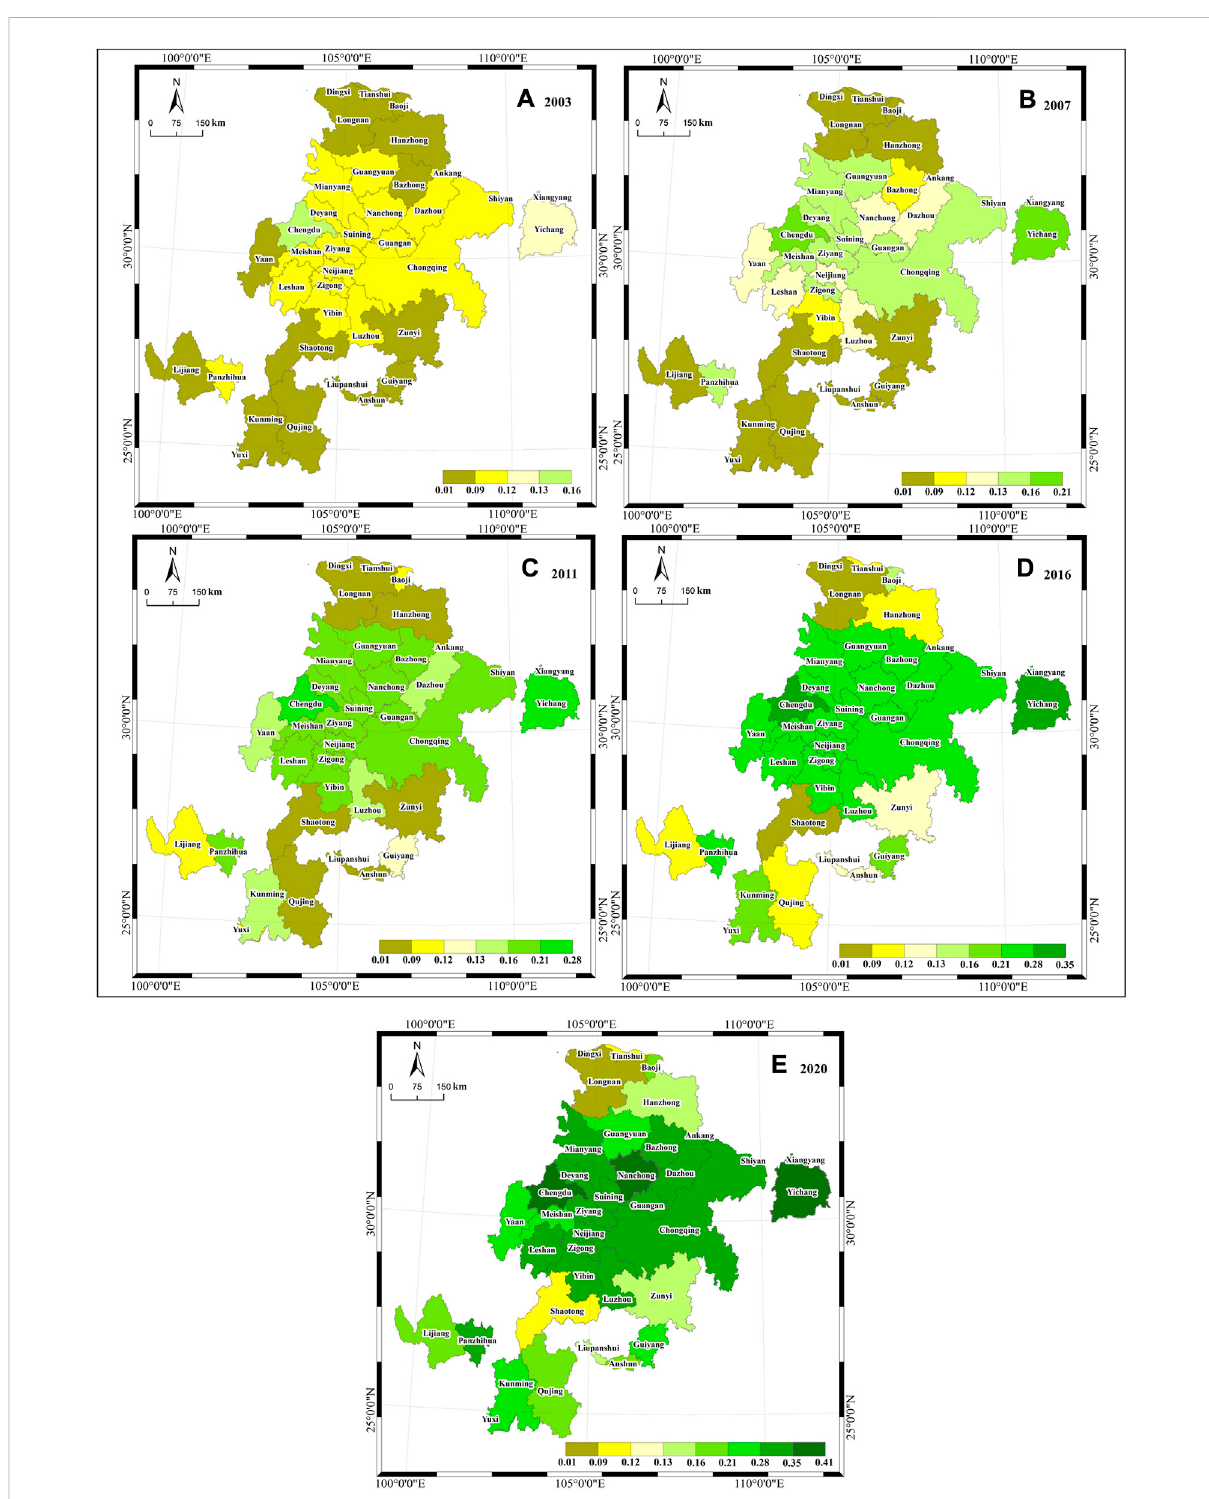
FIGURE 2 Evolution of ecological civilization in the upper reaches of the Yangtze River in 2003, 2007, 2011, 2016 and